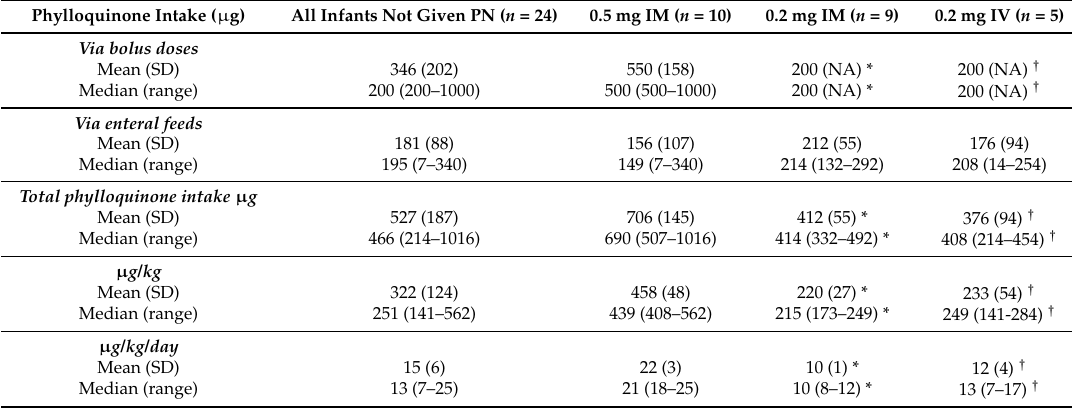
Table 5. Relative intakes of phylloquinone from bolus doses and enteral feeds together with total intakes at study completion for infants who did not receive parenteral nutrition.